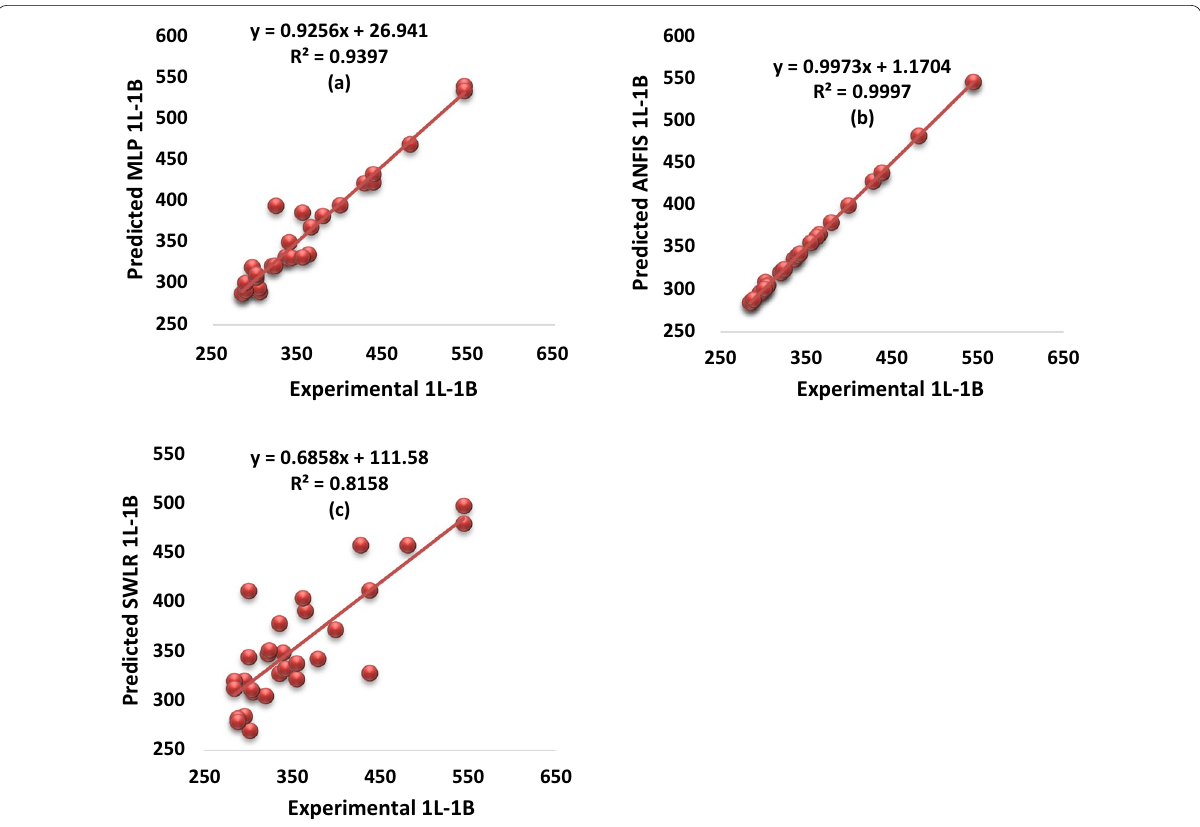
Fig. 1 Scatter plots for a MLP, b ANFIS and c SWLR for 1L-1B